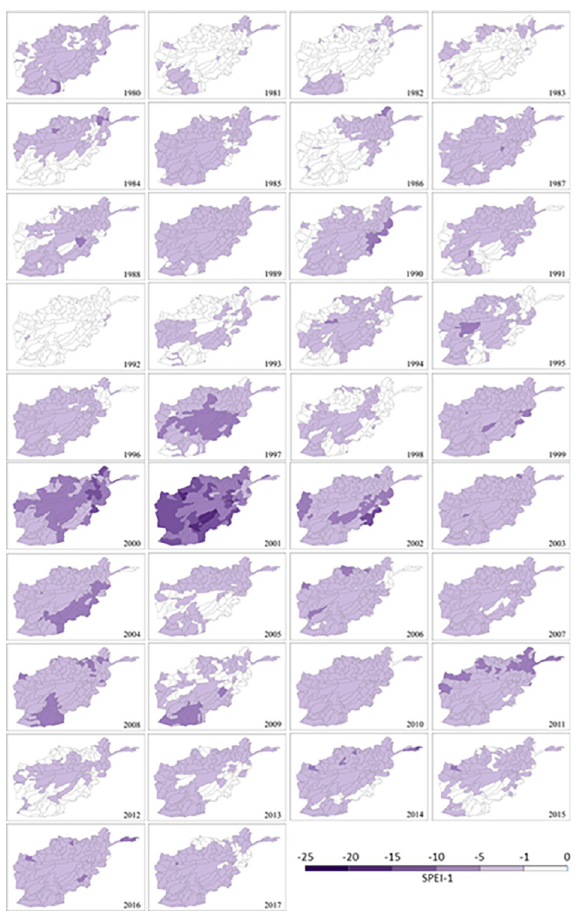
Fig 10. Spatial distribution of annual maximum drought severity at sub-catchment scale in Afghanistan for each year between 1980 and 2017 based on SPEI-1 (monthly scale).